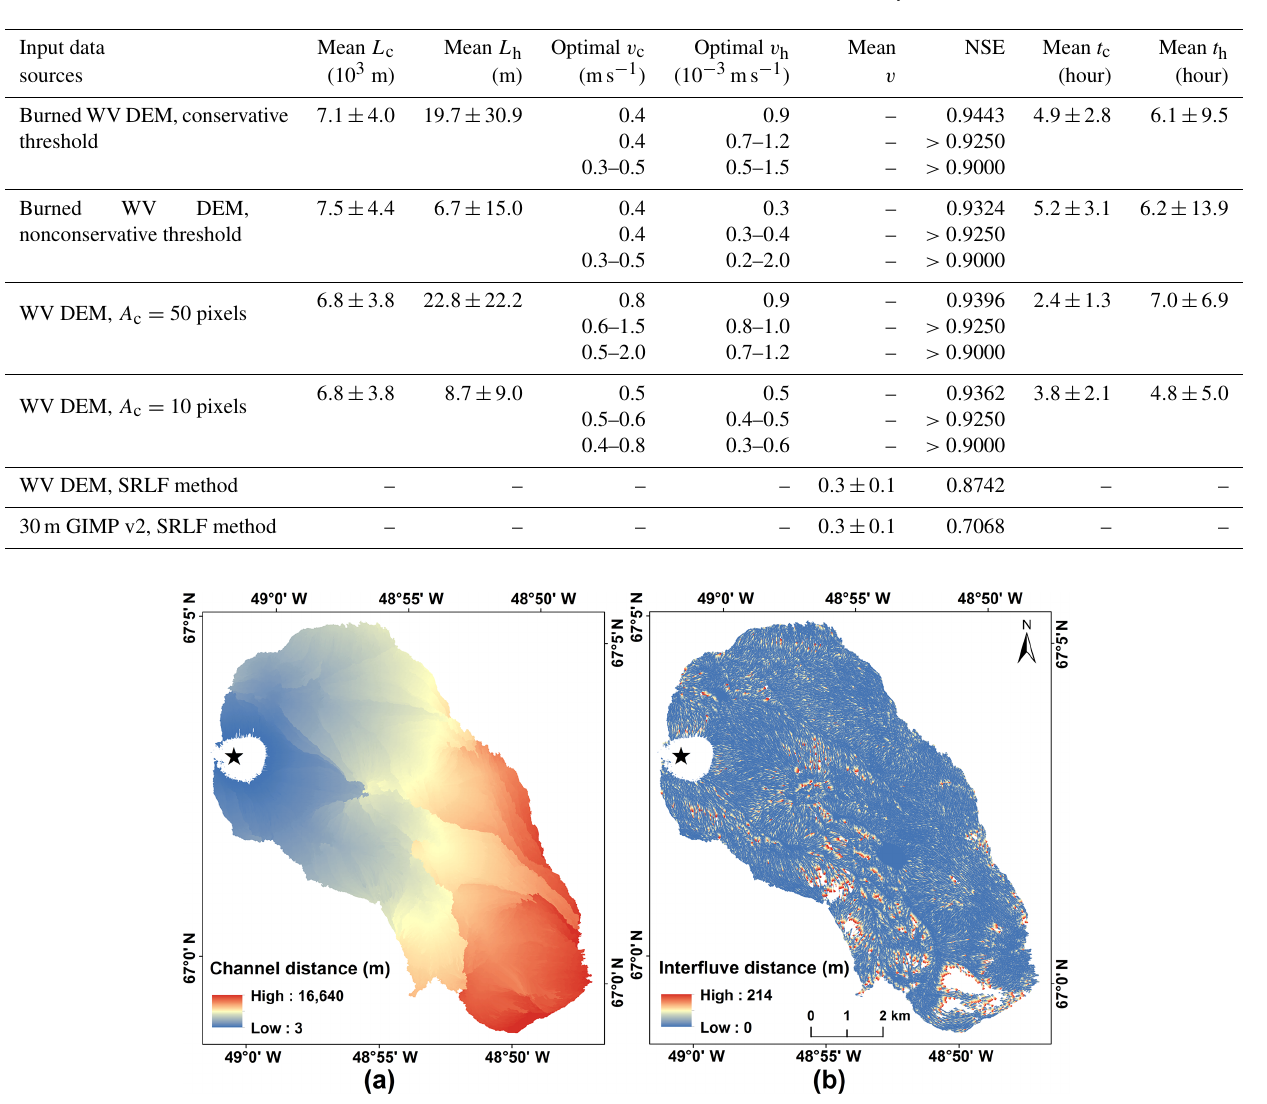
Table 1. Surface meltwater travel distances, velocities, and times in the Rio Behar catchment for July 2015.